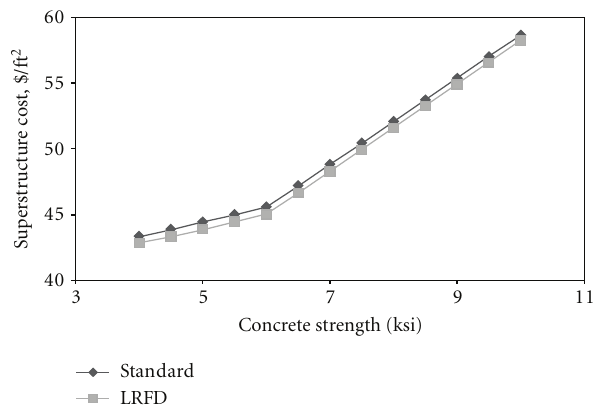
Figure 10: Approximate superstructure cost versus concrete strength.